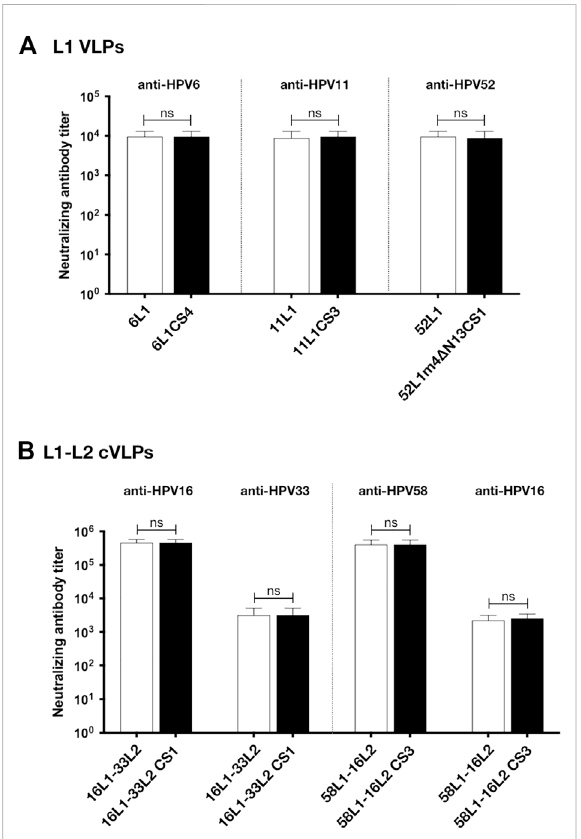
FIGURE 5 Immunogenicity analysis of 6L1CS4 VLPs, 11L1CS3 VLPs, 52L1m4 Δ N13CS1 VLPs, 16L1-33L2 CS1 cVLPs, and 58L1-16L2 CS3 cVLPs in mice. At 0, 4, and 8 weeks, BALB/c mice ( n = 5) were subcutaneously immunized with (A) 1 μ g of HPV6, −